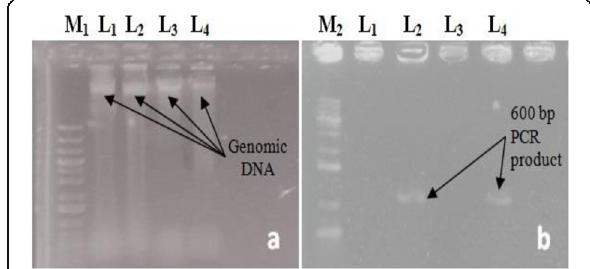
Fig. 8 a Represents the genomic DNA and b represents the PCR 1 : DNA of control Citrus reticulata Blanco. L 2 : DNA of transformed Citrus reticulata (L.) Blanco. L 3 : DNA of control Citrus sinensis (L.) Osbeck. L 4 : DNA of transformed Citrus sinensis (L.)